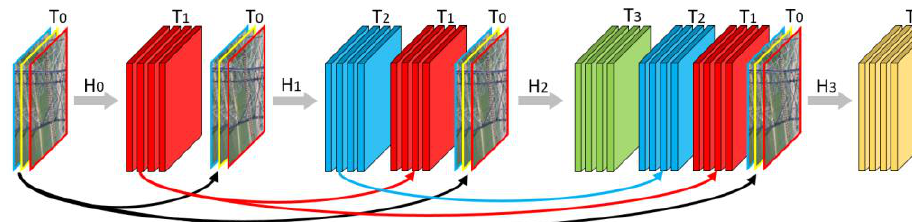
Figure 3. DenseBlock structure diagram.